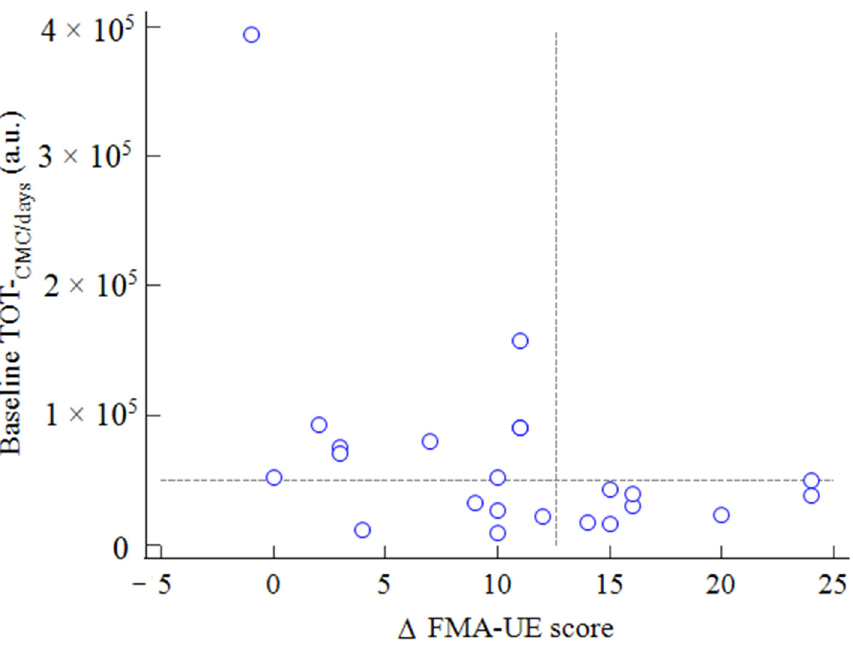
Figure 7. Rank correlation between baseline TOT- CMC/days and variations in the FMA-UE score after rehabilitation. The vertical reference line corresponds to the minimal clinically important difference for FMA-UE.